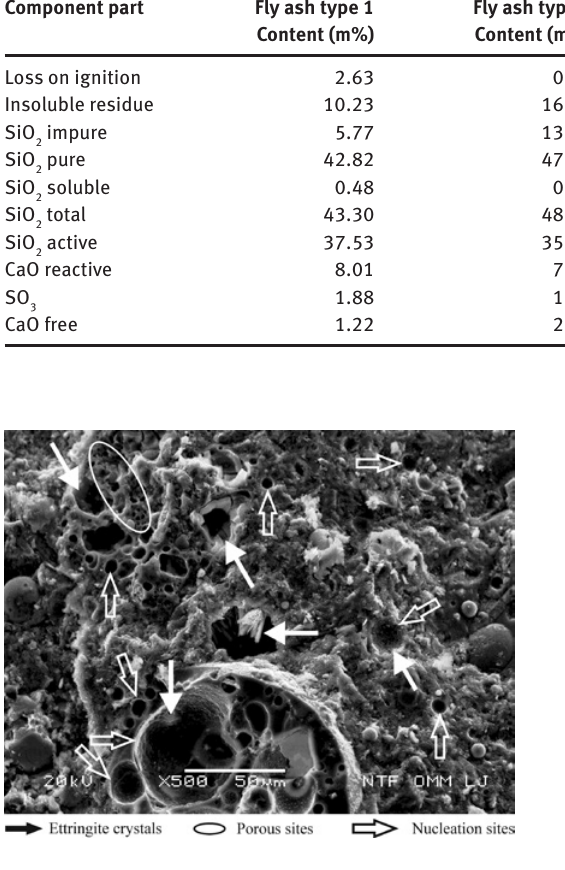
Figure 5 Micro fractography of the sample BI-DT air bubble with microcracks and ettringite crystals; SEM, SEI.